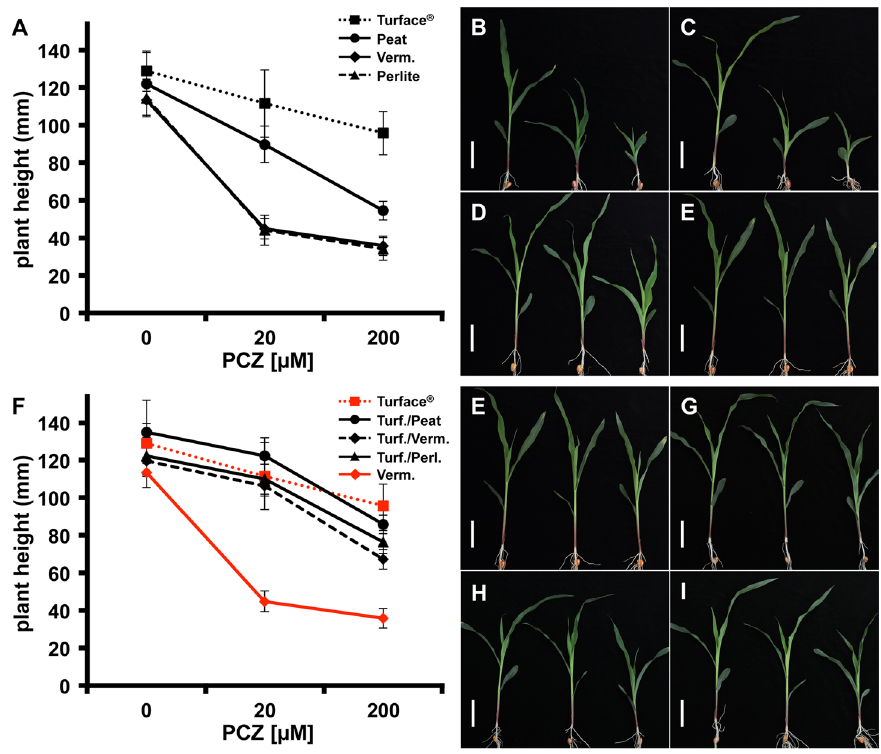
Figure 3. Plant growth response of maize seedlings treated with Pcz in different media substrates. (A–E) B73 maize seedlings grown for 11d in the light in either (B) Turface, (C) peat germinating mix, (D) vermiculite, or (E) perlite. (F–I) 1:1 (v/v) mixtures of (G) Turface/peat mix, (H) Turface/vermiculite, and (I) Turface/perlite. Plants were watered without (left), 20 m M (center) or 200 m M (right) of Pcz as needed. (A) Height of plants grown in pure media as well as (F) Turface 1:1 mixtures was measured from the root-shoot transition zone to the highest leaf collar using ImageJ 1.43. (A, F) Error bars represent standard deviation. Size bars indicate 5 cm.